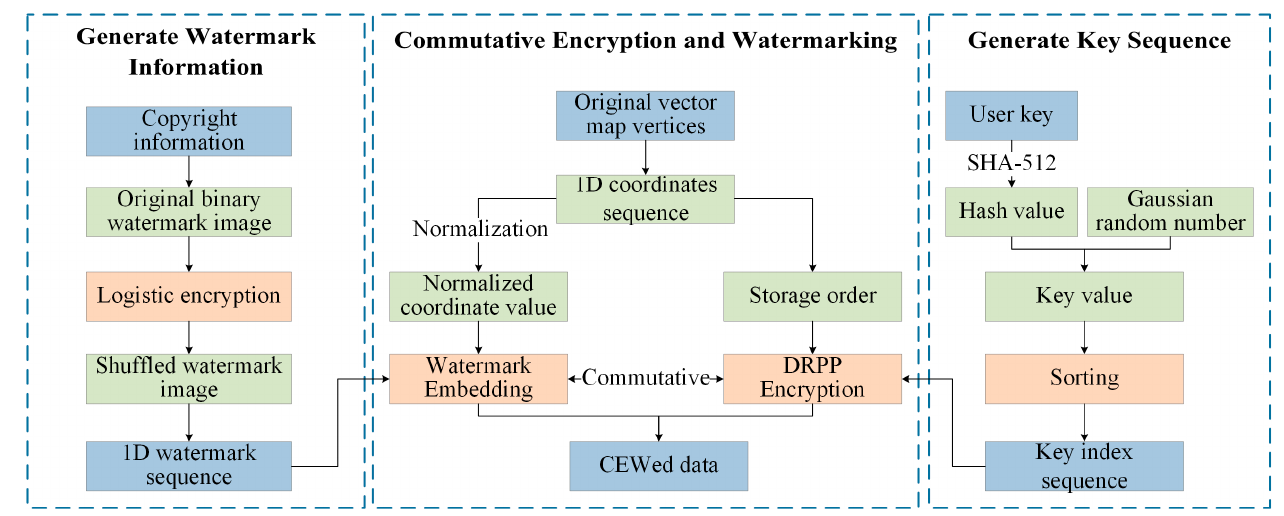
Figure 4. The diagram of the proposed CEW scheme.